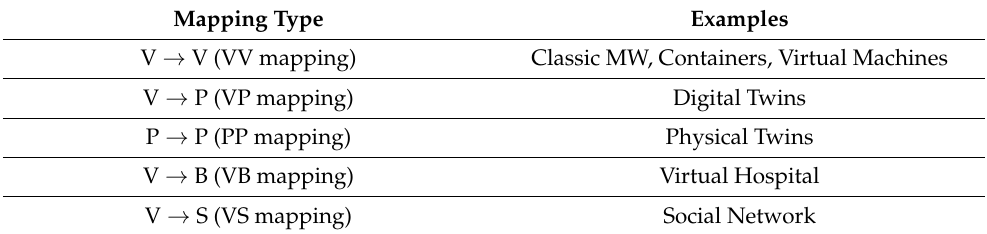
Table 2. Main mapping